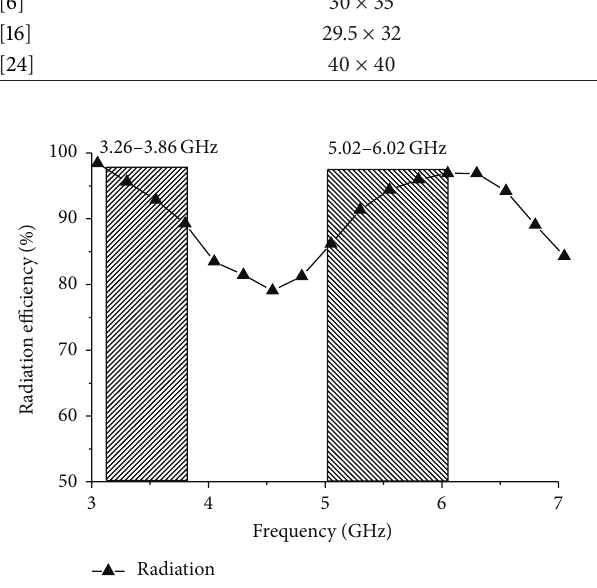
Figure 9: Radiation efficiency of the proposed antenna.